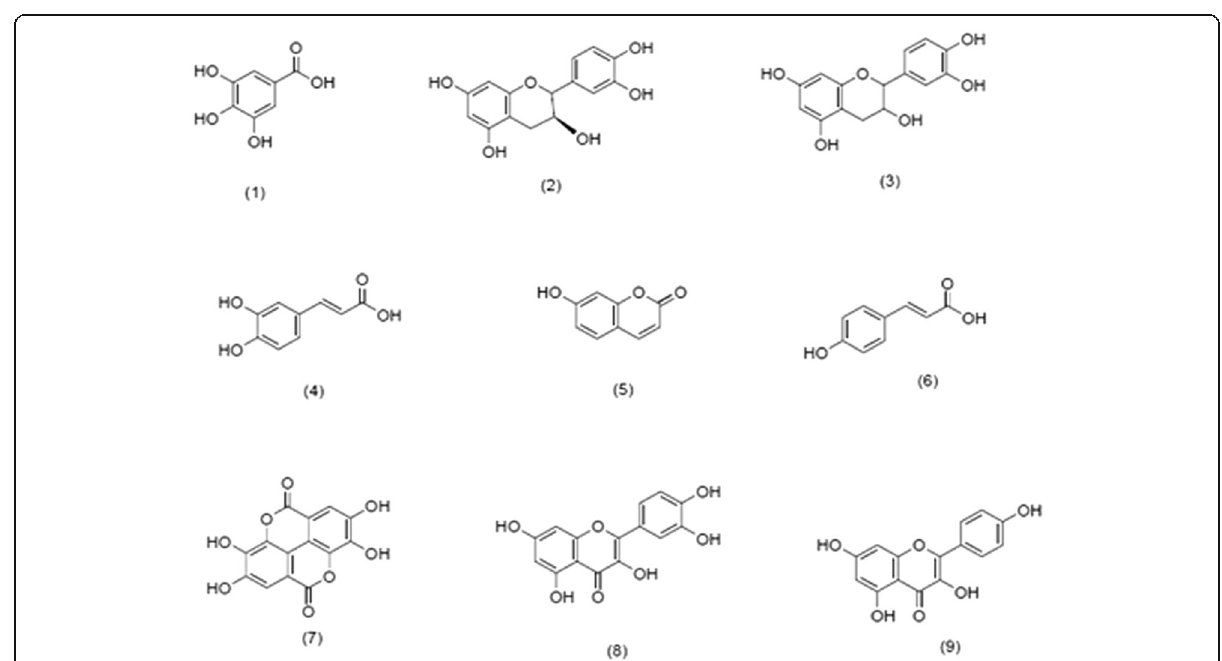
Fig. 6 Chemical structures of phenolic compounds detected in TES17